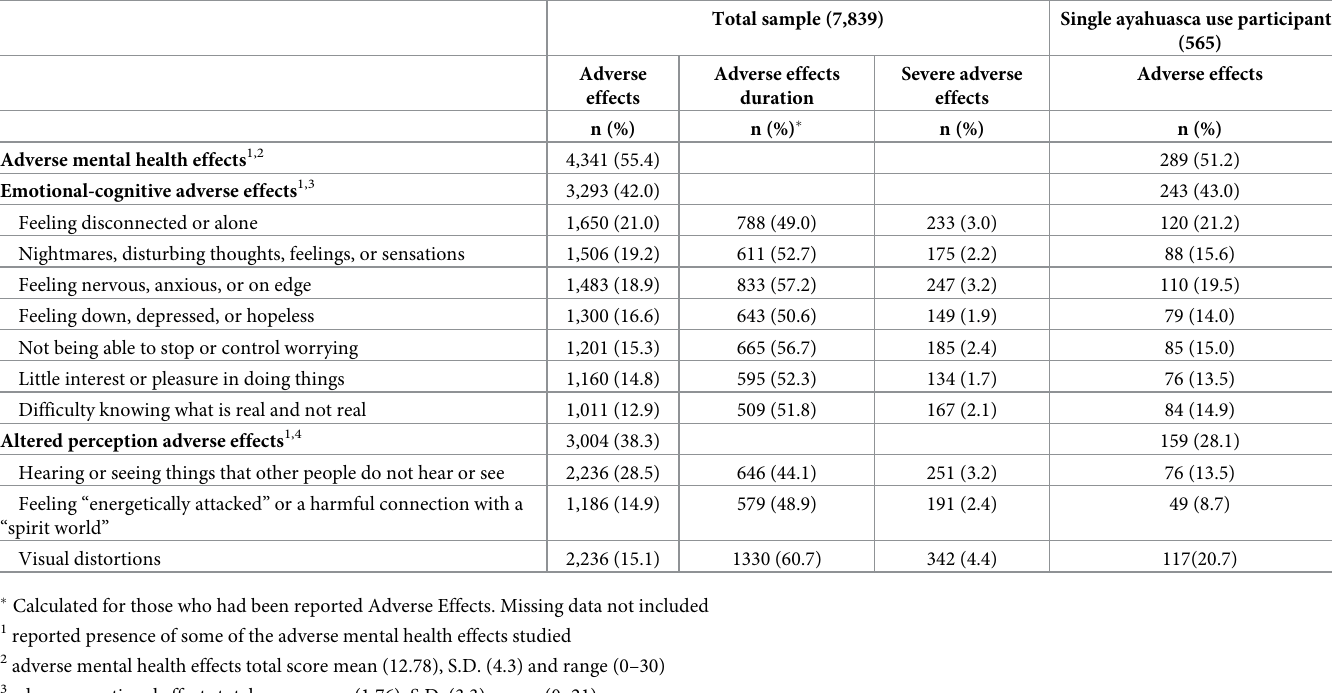
Table 3. Frequency of participants’ reported adverse mental health